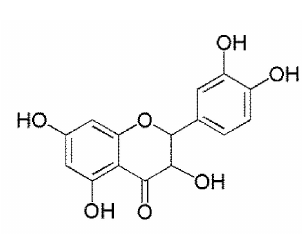
Figure 1. Chemical structure of taxifolin (TAX).